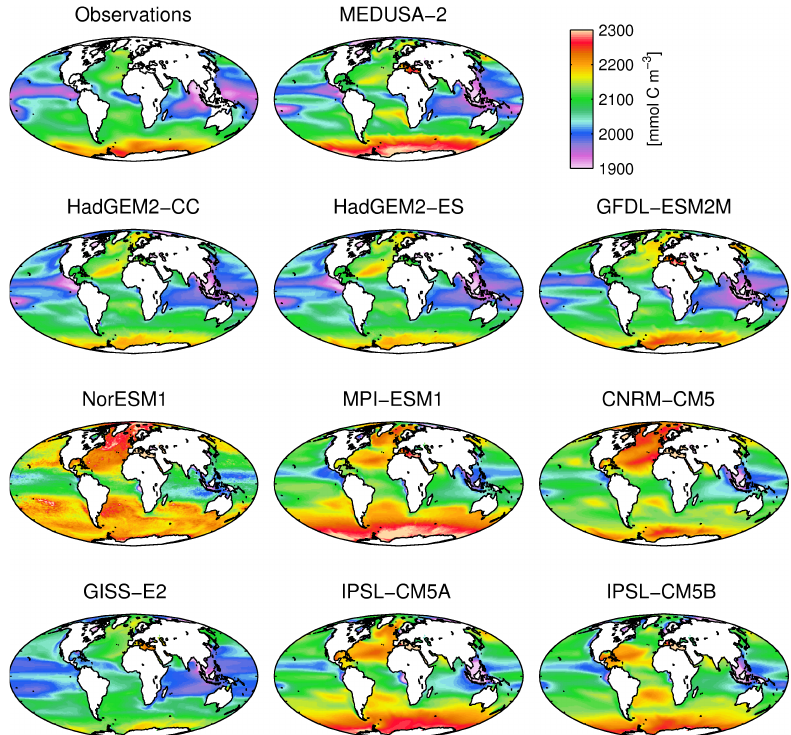
Fig. 46. Intercomparison of annual mean surface dissolved inorganic carbon for M EDUSA -2.0 and a range of comparable CMIP5 models. Surface DIC in mmolCm − 3 .